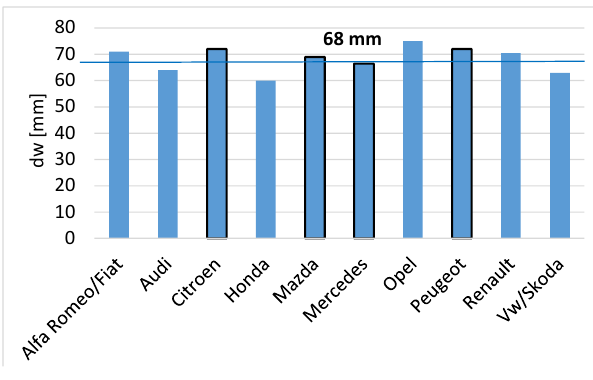
Fig. 3. Impeller diameters of each CP